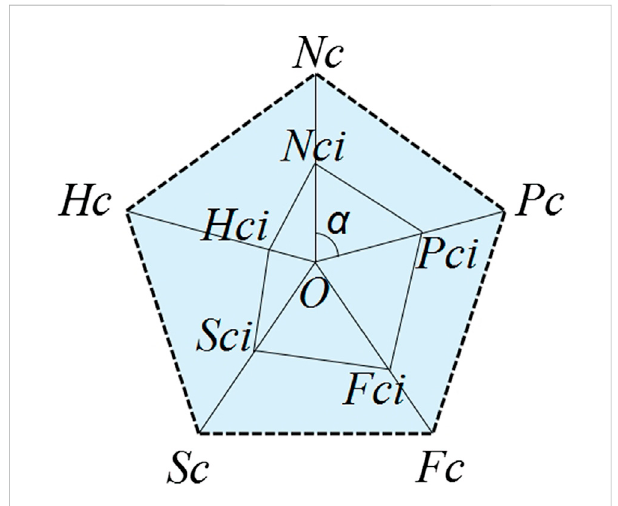
FIGURE 4 Regional livelihood capital